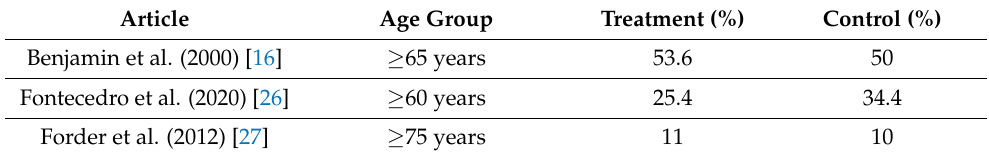
Table 3. Percentage of elderly participants reported in three studies providing this